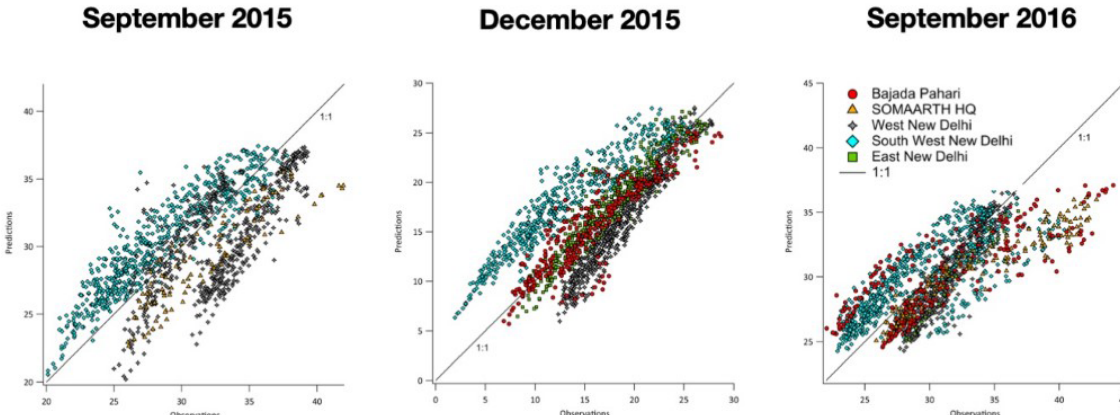
Figure 5. Evaluation of WRF-simulated meteorological fields versus ground observations. Table 9. Quantification of WRF model biases in meteorological